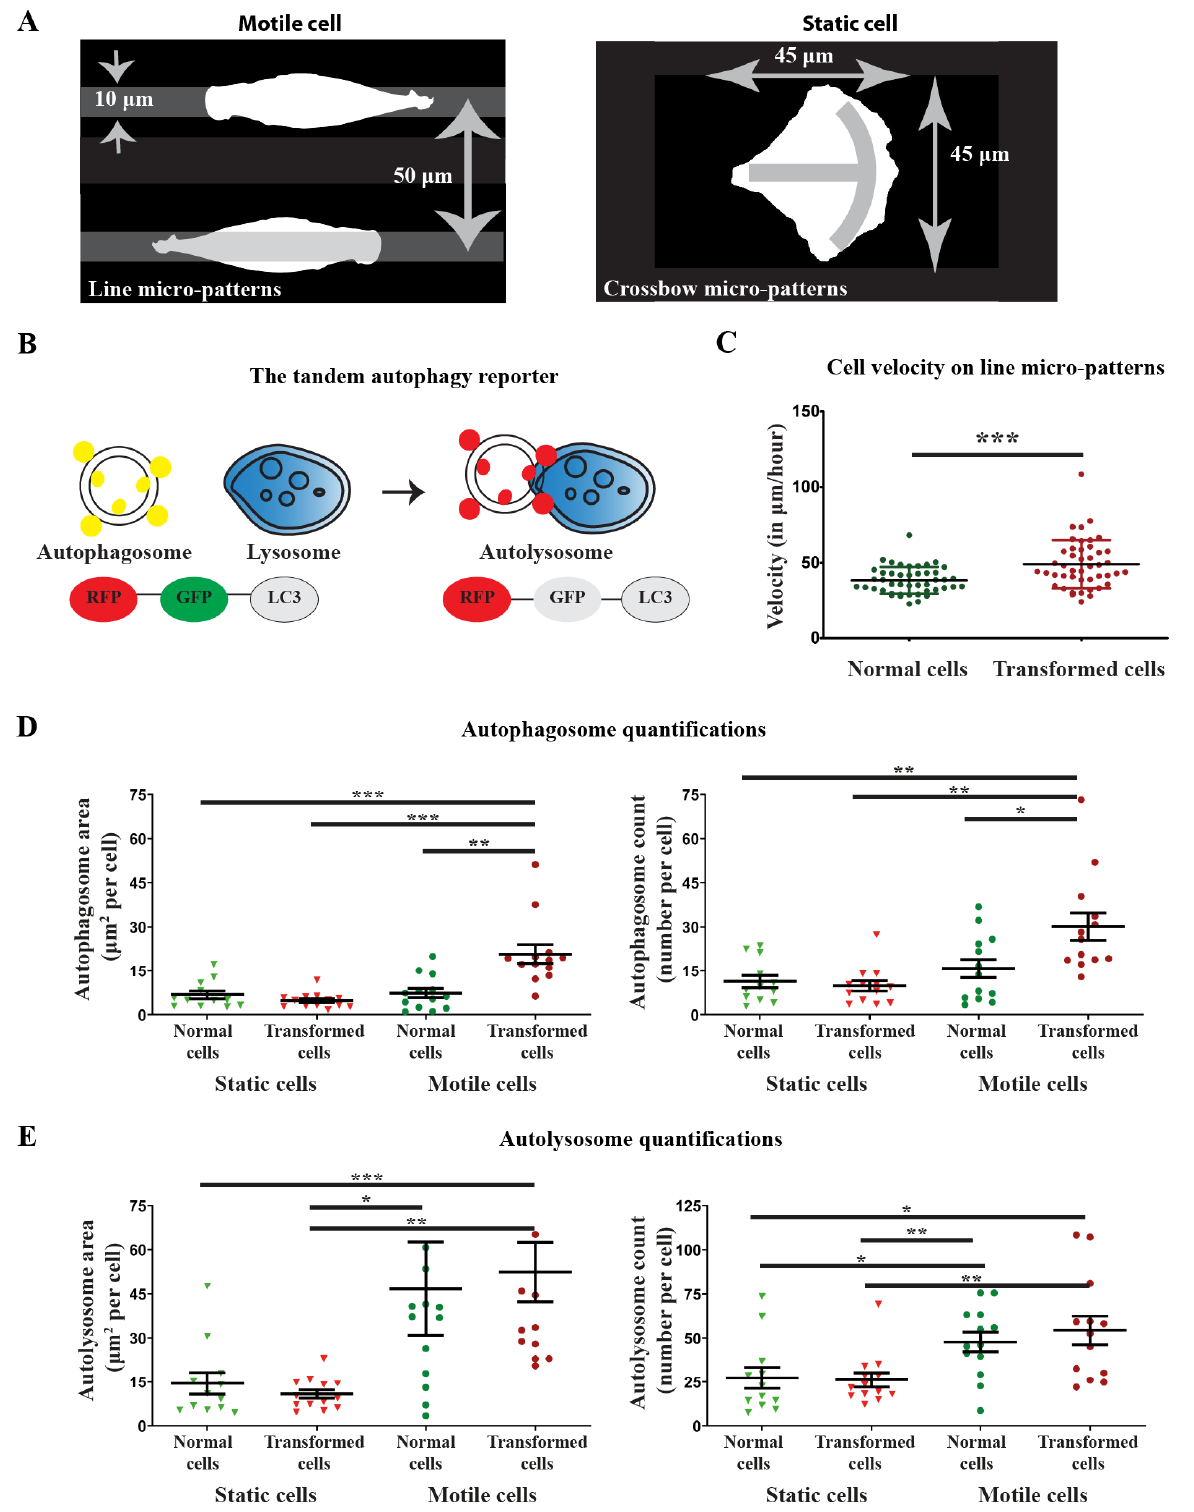
Figure 2. Strategy to study the spatial-temporal localization of LC3 compartments (autophagosomes and autolysosomes) during directional migration. ( A ) Micro-patterns with fibronectin coating were used to force cells to migrate directionally (line micro-pattern) or keep them static (crossbow micro-pattern). ( B ) A tandem reporter RFP-GFP-LC3 was used to monitor the localization of autophagosomes (red + green fluorescence, represented as yellow) and autolysosomes (red fluorescence). After fusion with lysosomes, due to the low pH environment, GFP is quenched and only RFP fluorescence remains. ( C ) Ras-transformed cells (HEK-HT-H-RasV12, in red) are faster on line micro-patterns than isogenic normal